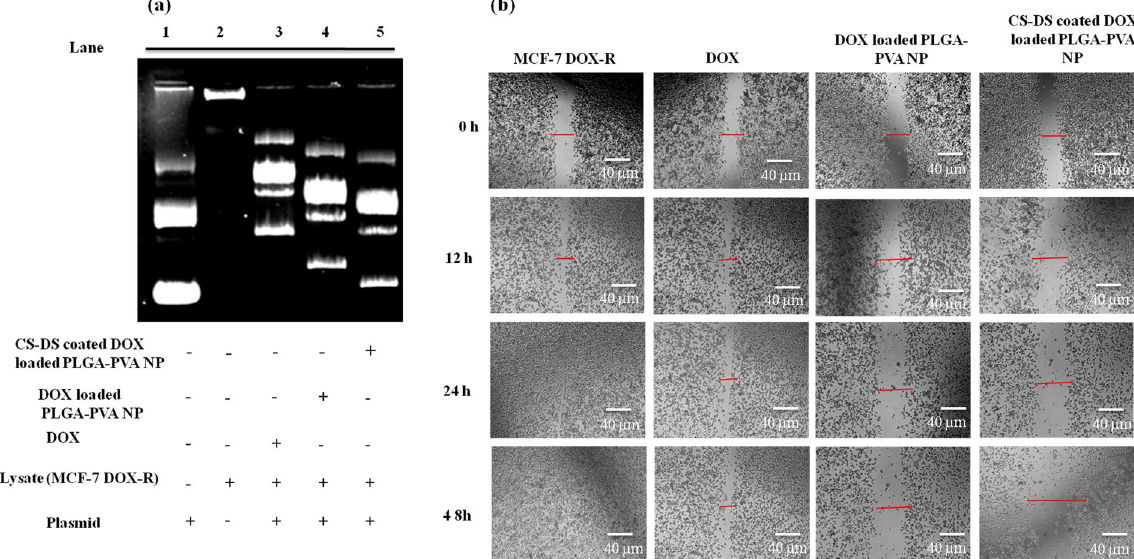
Figure 3. CS-DS coated DOX loaded PLGA-PVA -NP inhibits topoisomerase activity and retards cell migration of MCF-7- DOX-R cells. ( a ) Inhibition of topoisomerase activity by DOX nanoparticles. ( b ) Effect of DOX nanoparticles on cell migration of MCF-7- DOX-R cells. Images shown here were the representatives of three independent